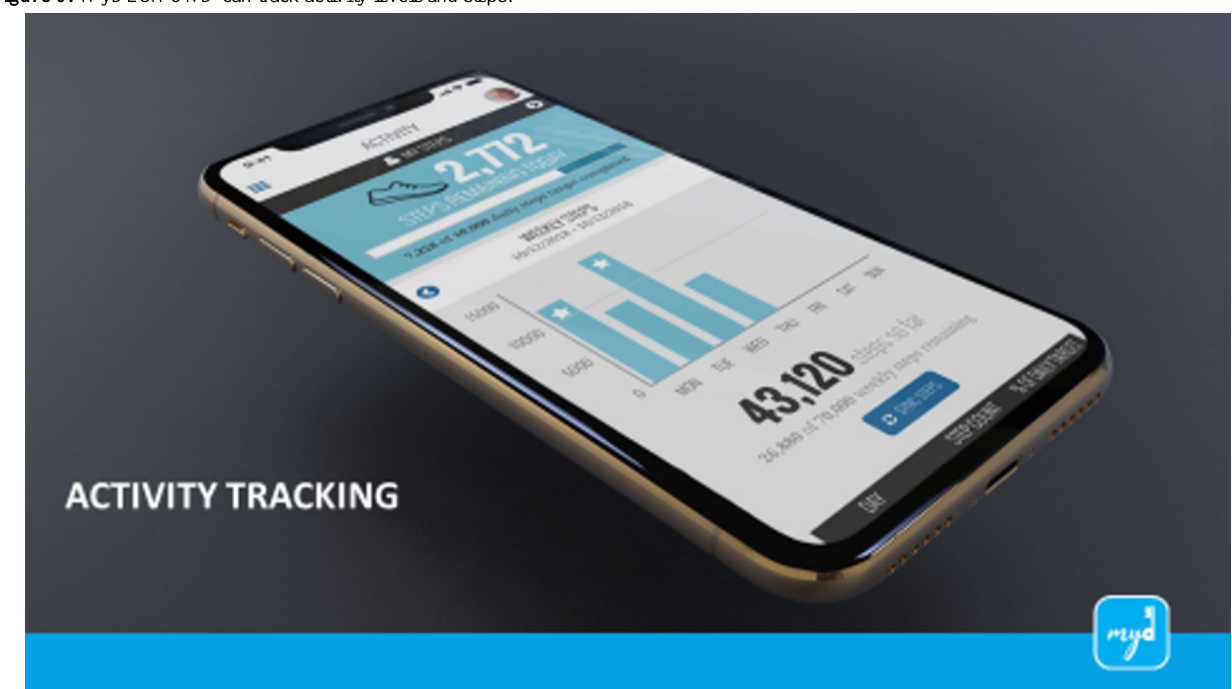
Figure 6. MyDESMOND can track activity levels and